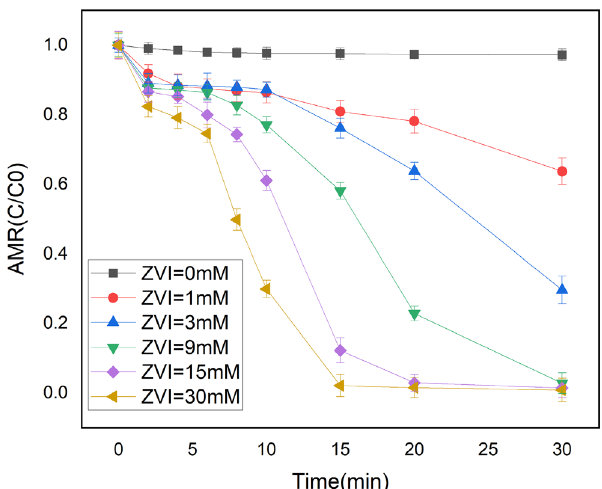
Fig. 3 Effect of solution pH on AMR degradation in persulfate–ZVI = 6 mM, system. [AMR] = 50 mg/L, [PDS] = 6 mM, [ZVI] = 15 mM, Temp. = 25 0 0 0 0 °C. pH i and pH f are summarized in Table